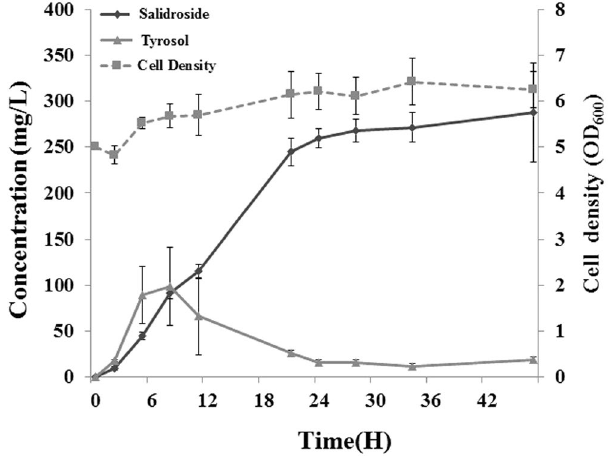
Figure 6. Production of salidroside using strain B-SAL2 after optimization of incubation time and cell concentration.